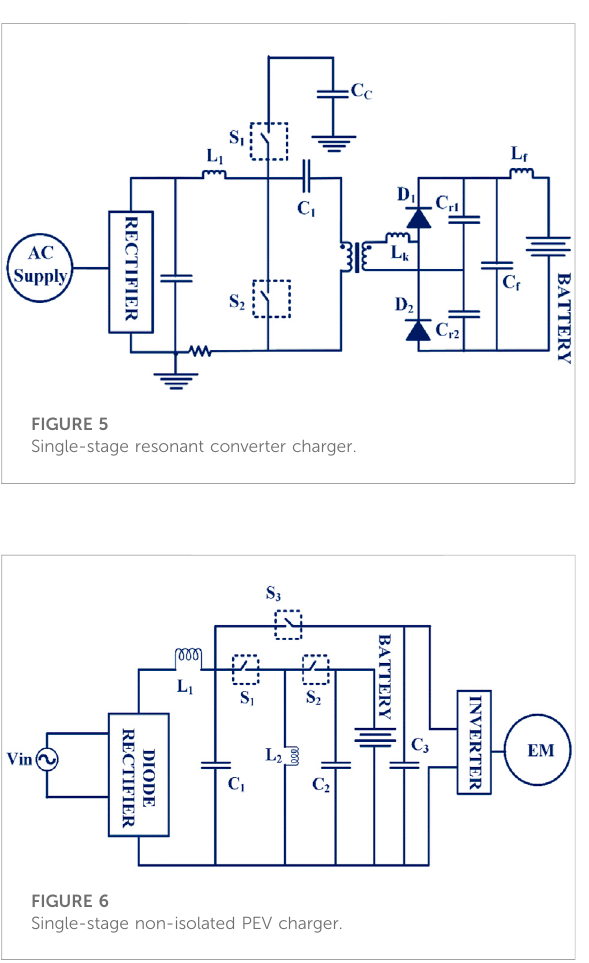
FIGURE 6 Single-stage non-isolated PEV